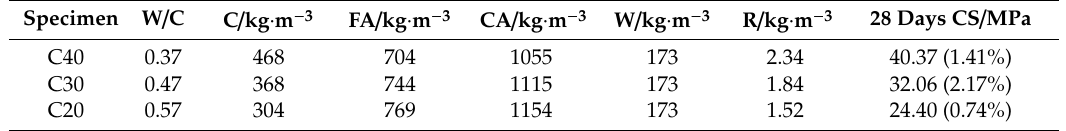
Table 2. Mixture proportion and compressive strength of